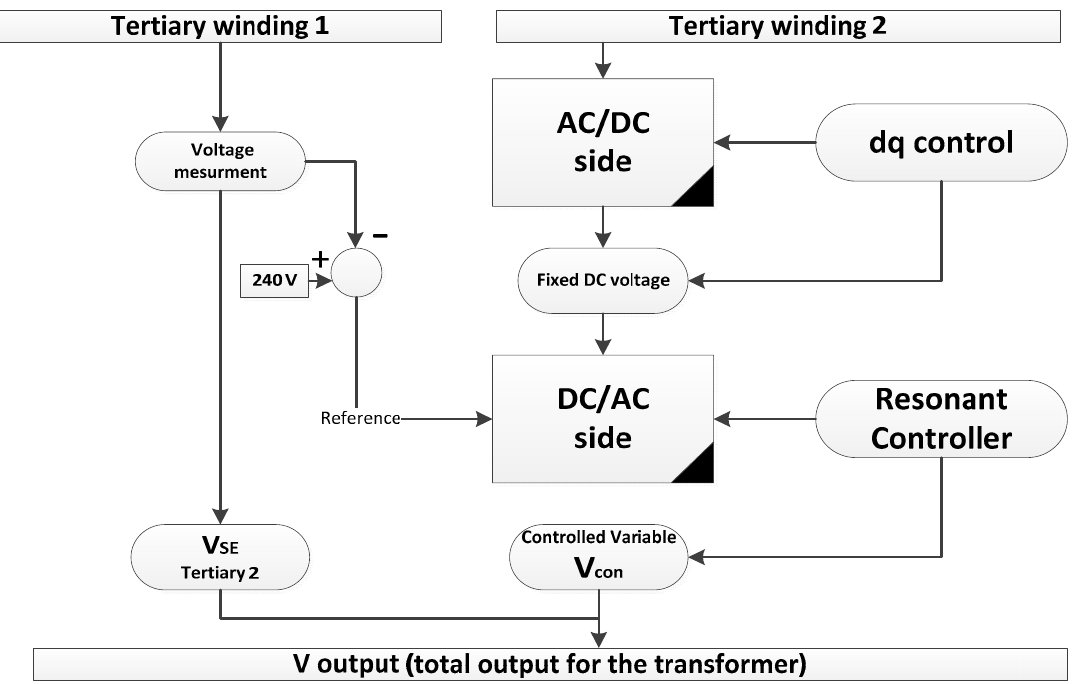
Figure 8. The proposed control logic. A schematic diagram of the overall control of the output voltage.